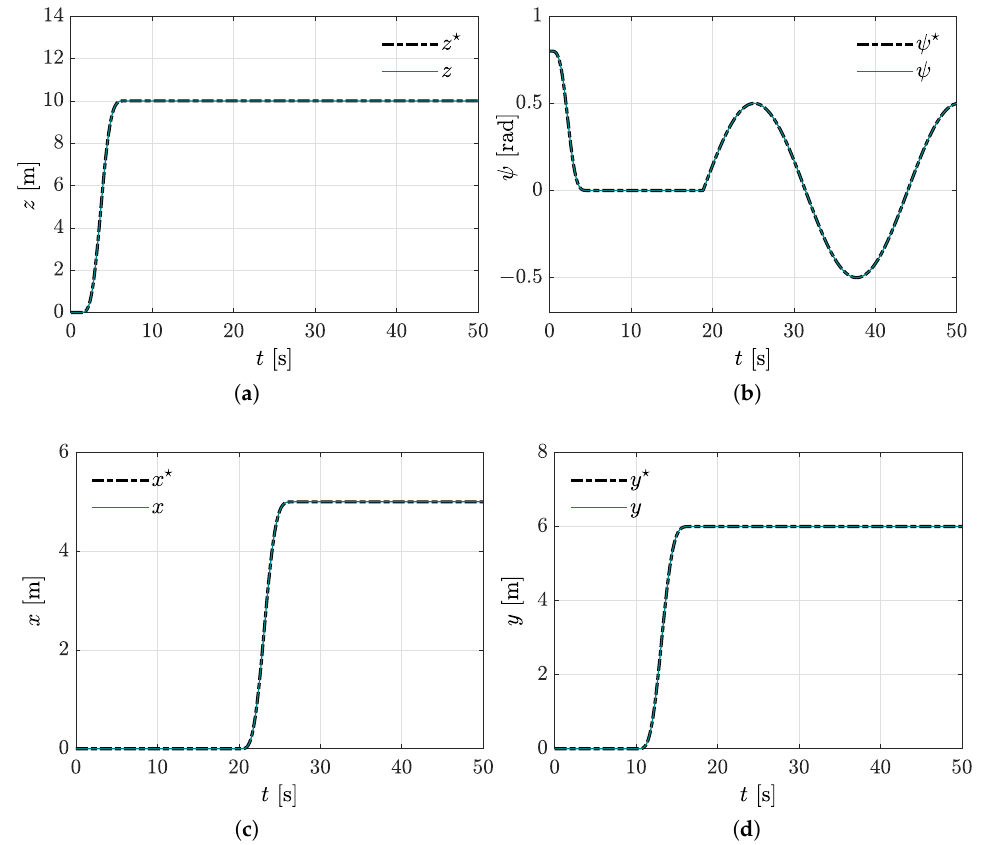
Figure 3. Controlled motion without forced vibrations. ( a ) Controlled motion towards the desired vertical position. ( b ) Controlled yawing motion. ( c ) Controlled x position. ( d ) Controlled y